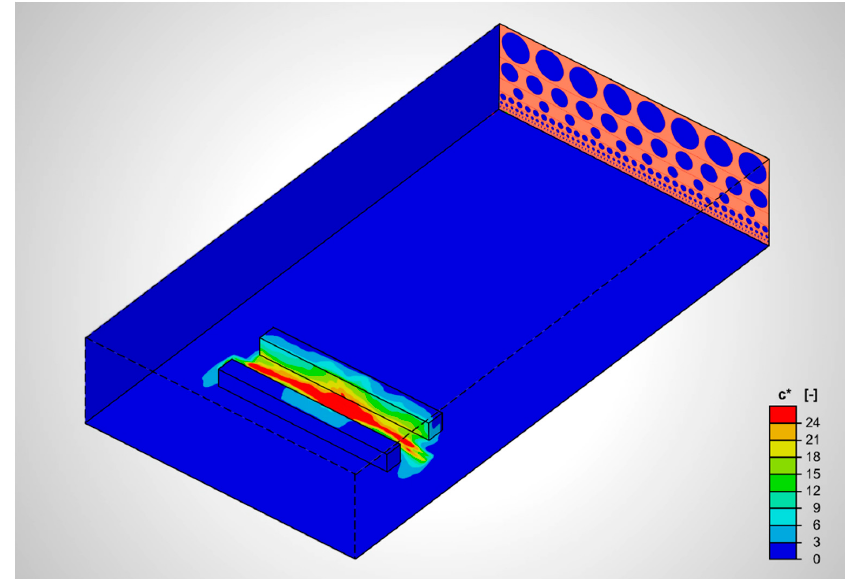
Figure 5. Overview of the virtual wind tunnel. Surfaces are colored by normalized concentration. The velocity inlets are marked with orange.